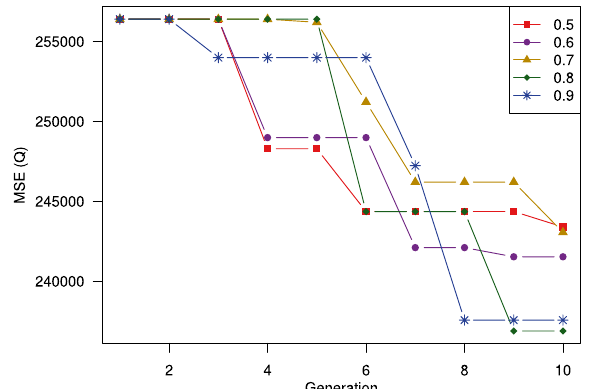
Figure 12. Impacts of selecting best individuals percentage on model performance. Selecting the best individual with the probability of 0.9 get the best performance.